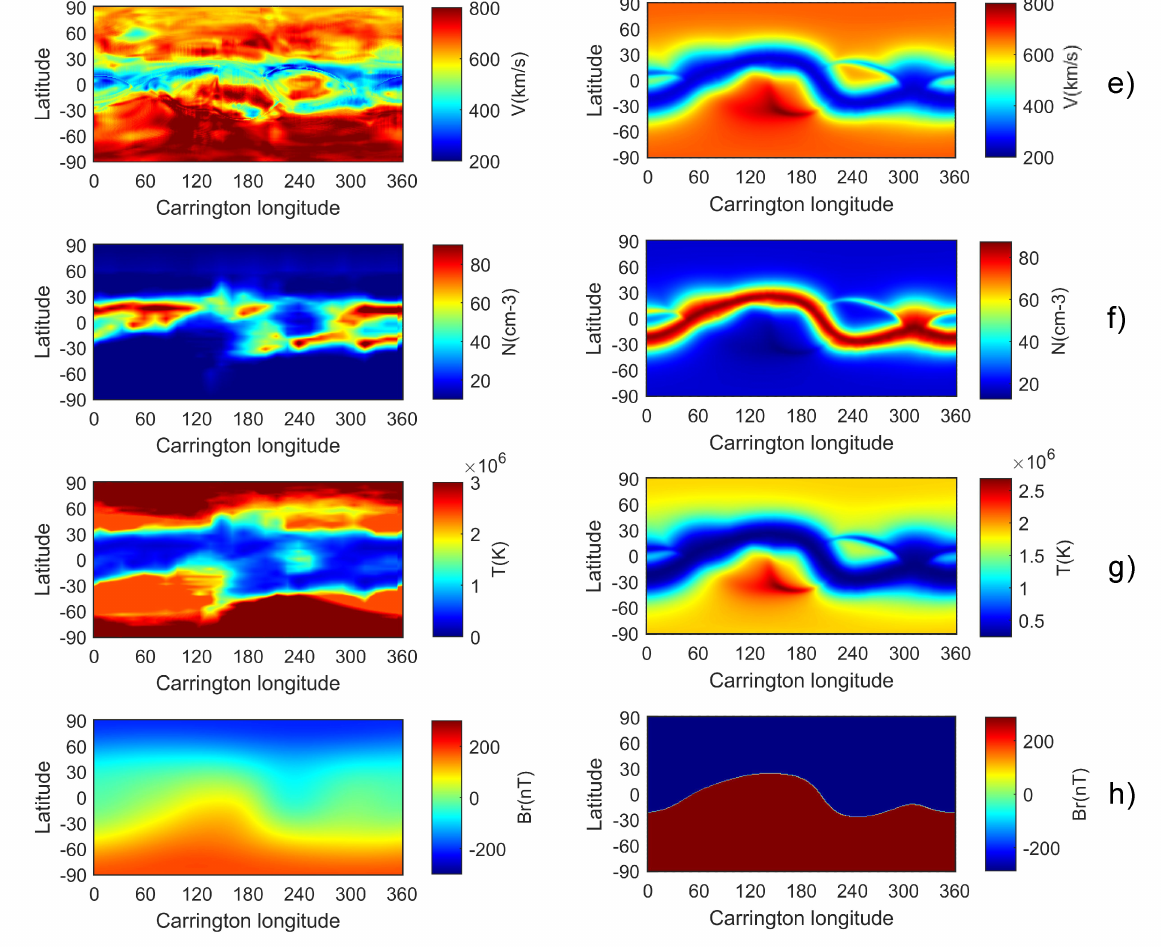
Figure 4. The global distribution of ( a ) velocity (Vr), ( b ) density (N), ( c ) temperature (T) and ( d ) radial magnetic field (Br) at the inner-boundary derived from the new method using multiple observations and ANN, and the global distribution of ( e ) Vr, ( f ) N, ( g ) T, and ( h ) Br derived from the method only based on the WSA model during CR2062. The x axis is the Carrington longitude, and the y axis is the